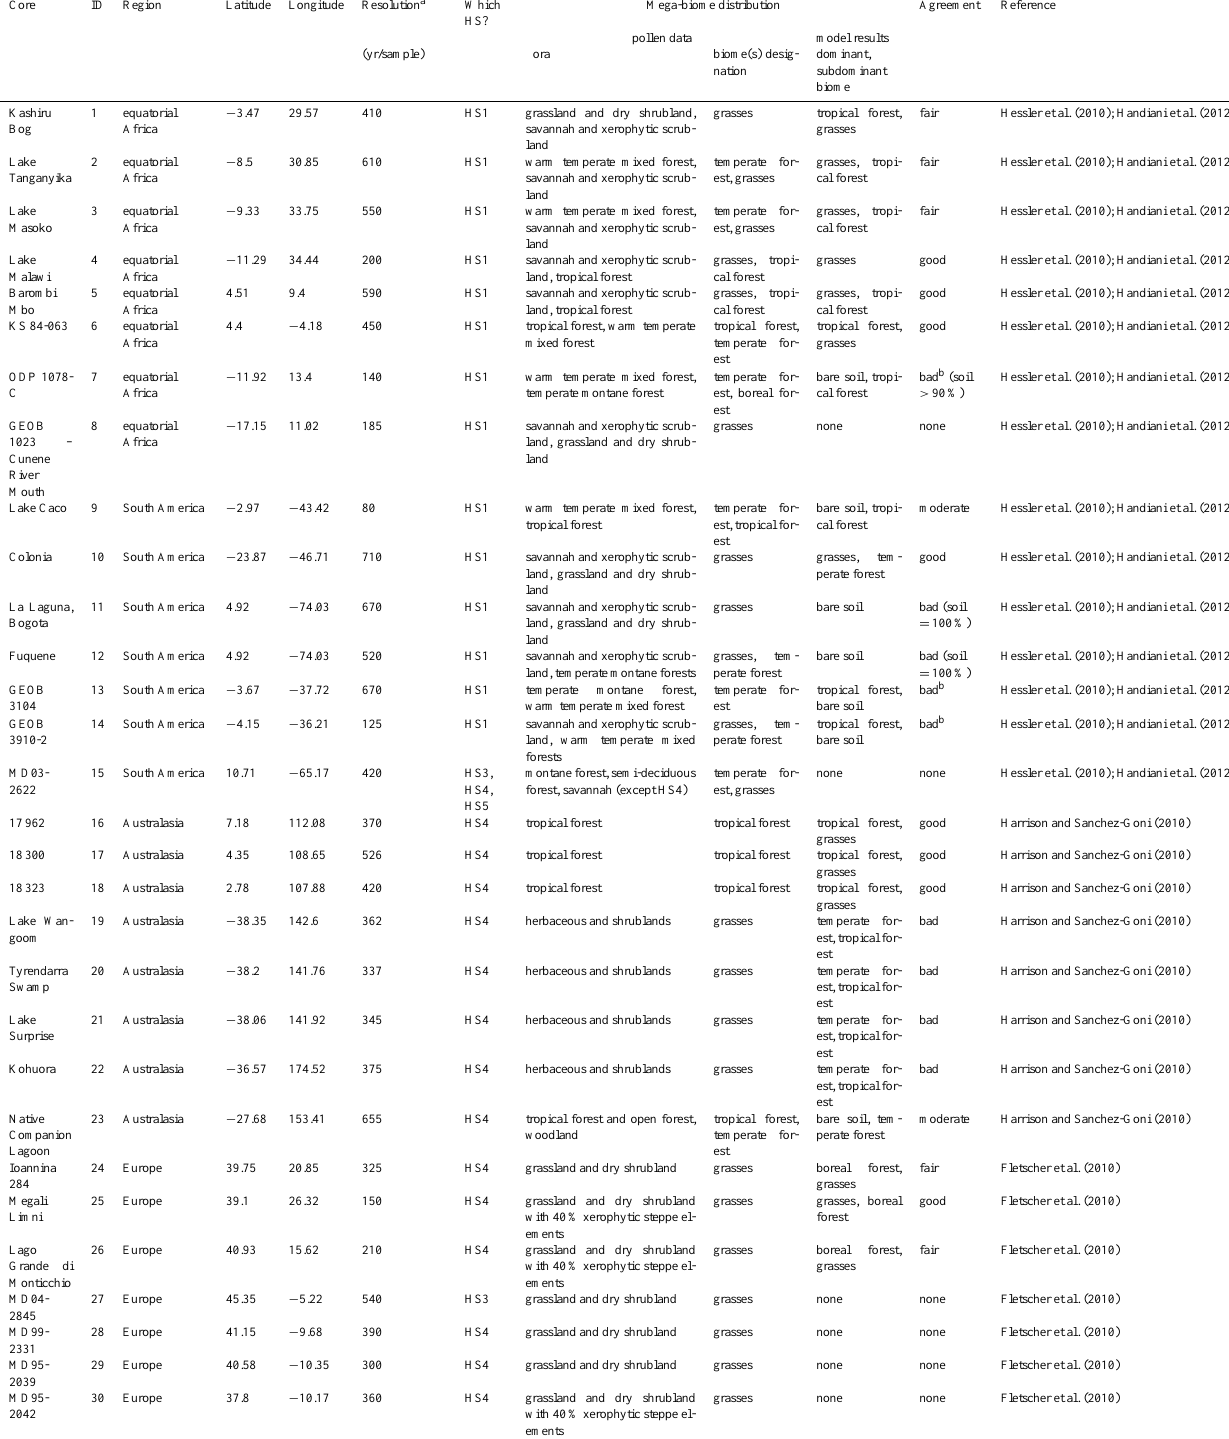
Table 4. Comparison of mega-biomes during Heinrich stadials between pollen reconstructions (references are included in the table) and simulated vegetation (compiled from HS_exp using the ORCHIDEE vegetation model). Note that simulated C3 and C4 grasses are merged into one mega-biome because pollen-based biome reconstructions do not allow us to distinguish between the two